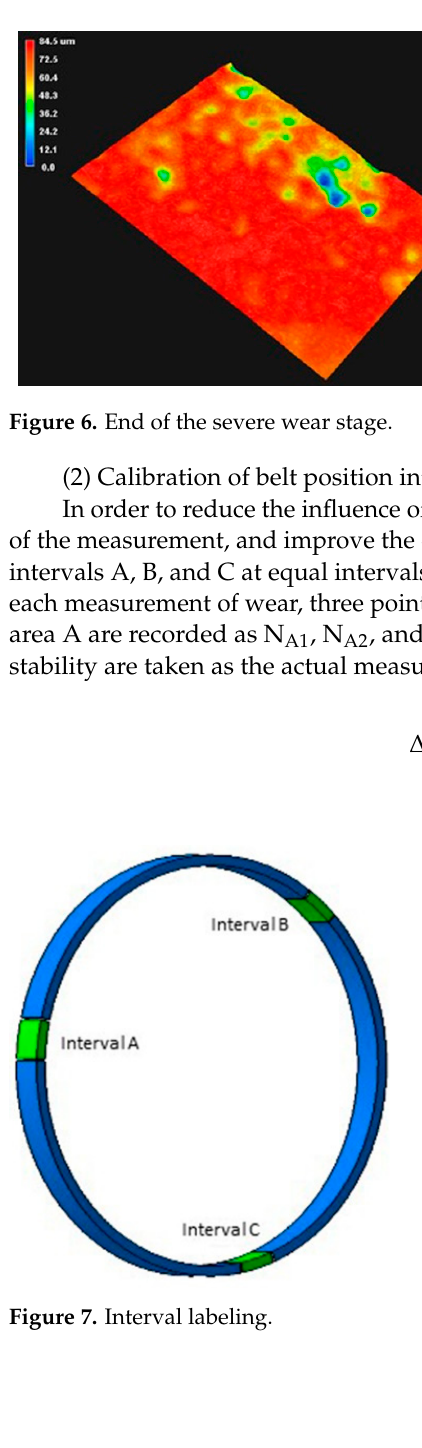
Figure 8. Actual interval labeling. (3) Abrasive belt fixture For the sanding belt within the interval length, researchers should fix the space posi- tion of the microscope lens and the position of the operating platform while framing. Meantime, the belt should be fixed by the self-designed special 3D printing fixture, as shown in Figure 9. The fixture is made of PLA material, which will avoid the damage of the microscope table due to touch and friction. By choosing this material, the repeatability of the measurement field will be maximized and the influence of random errors can be reduced, which will ensure the consistency and integrity of the measurement, as well as improve the data credibility.